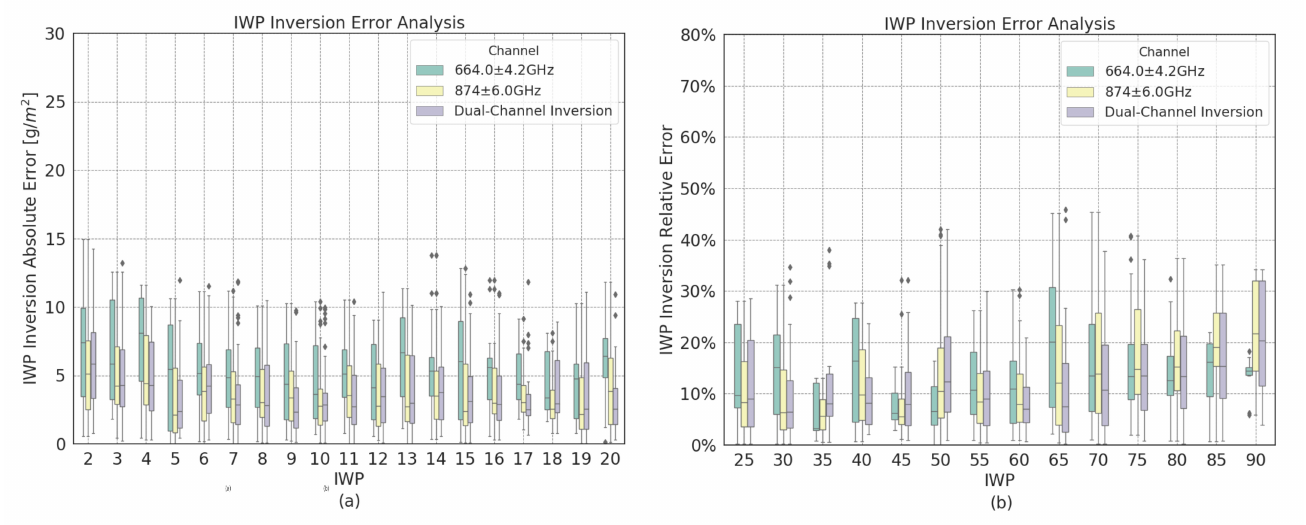
Figure 8. IWP inversion absolute error analysis of three different channels. ( a ) Absolute error analysis; ( b ) relative error